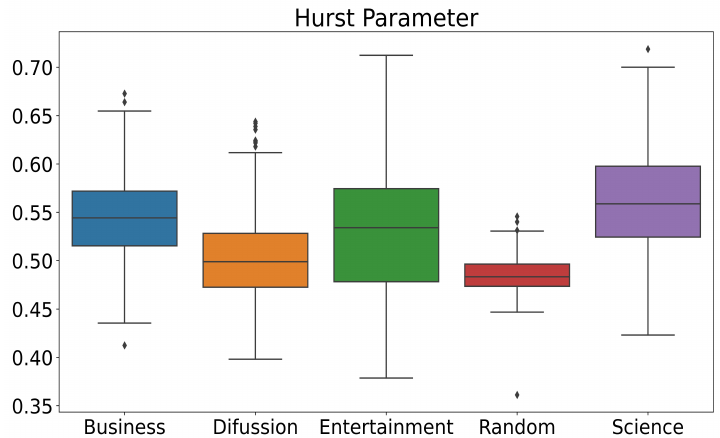
Figure 2. Box plots comparison of the Hurst parameter. From left to right: business, diffusion of science, entertainment, random and scientific texts.